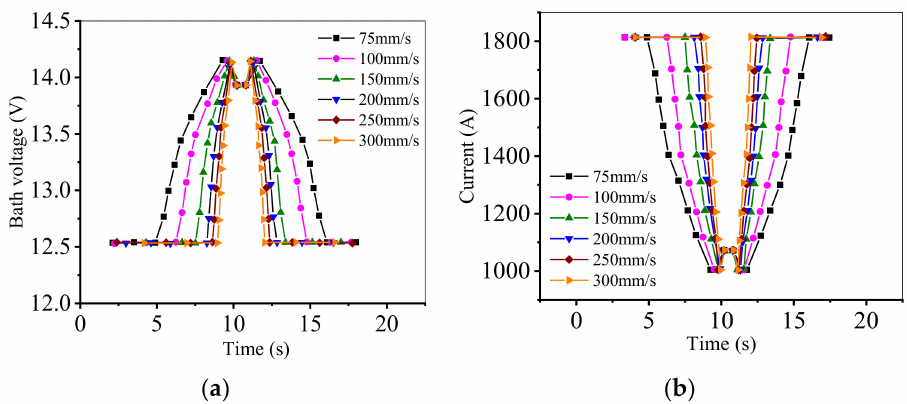
Figure 19. The variation of parameters with different brush cleaning speeds. ( a ) Bath voltage; ( b ) Current.